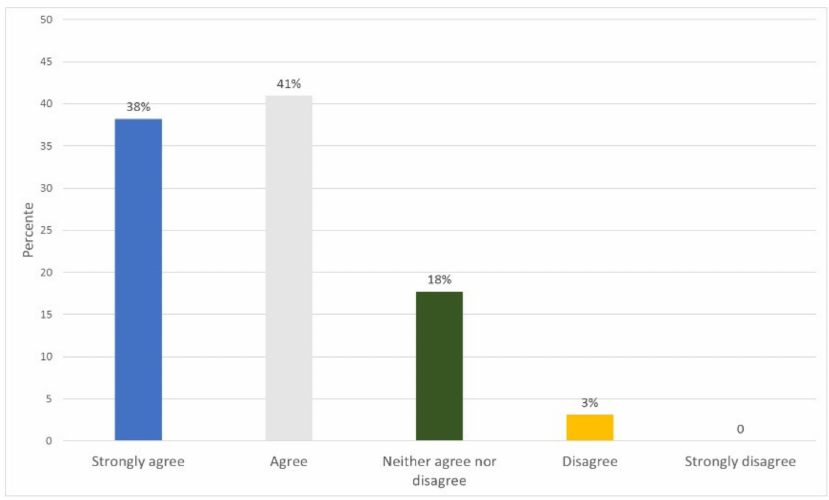
Figure 19. Usability survey results.